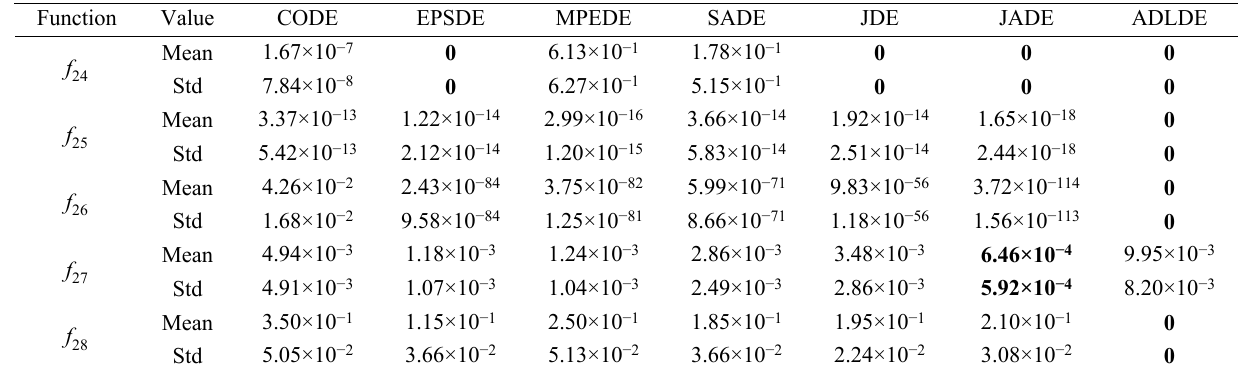
Table A3 Function error values of benchmark functions when D = 30.